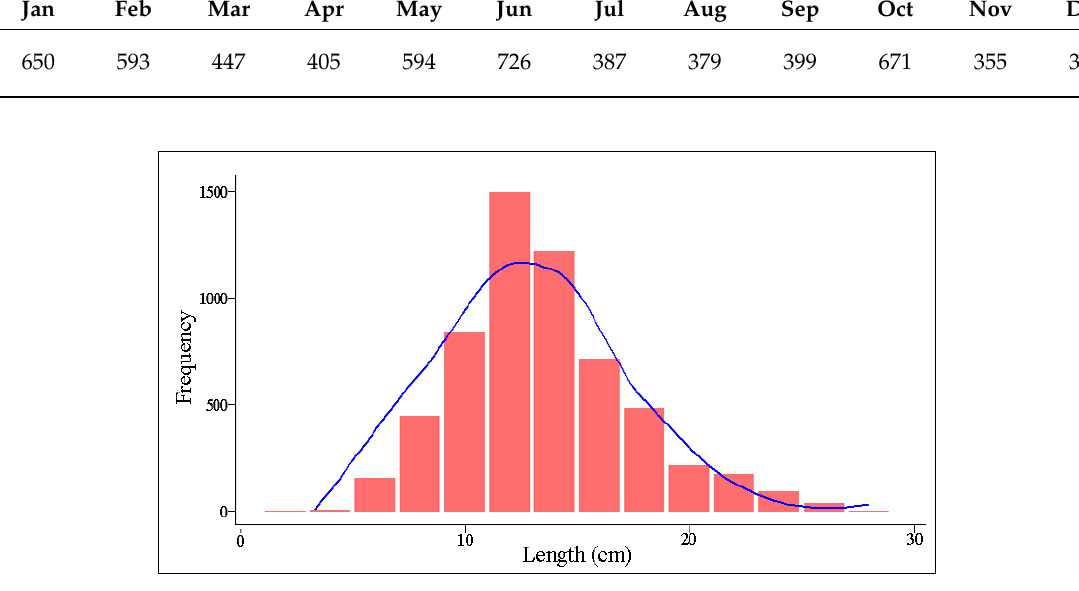
Table 1. The number of samples collected monthly from January to December 2018.